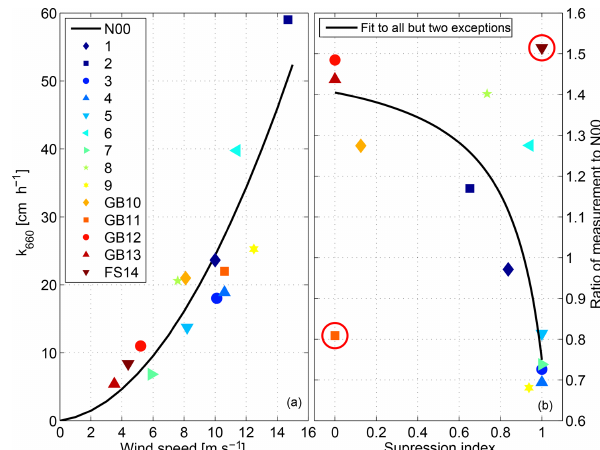
Figure 4. Individual dual-tracer measurements that contribute to the N00 (solid line) parameterization (a) . The relationship of the gas suppression ratio to the measurement and N00 ratio (b) . The solid line in (b) is a fit to the suppression to measurement and N00 relationship. A higher suppression ratio indicates a longer influence of gas transfer suppression on the datapoint. The two red circles de- note the outlier points that are discussed in the text. The solid black line is a fit using the function y(x) = a 1 + a 2 · 1 . The fit coeffi- x − a 3 cients are a 1 = 1 . 52, a 2 = 0 . 14 and a 3 = 1 .